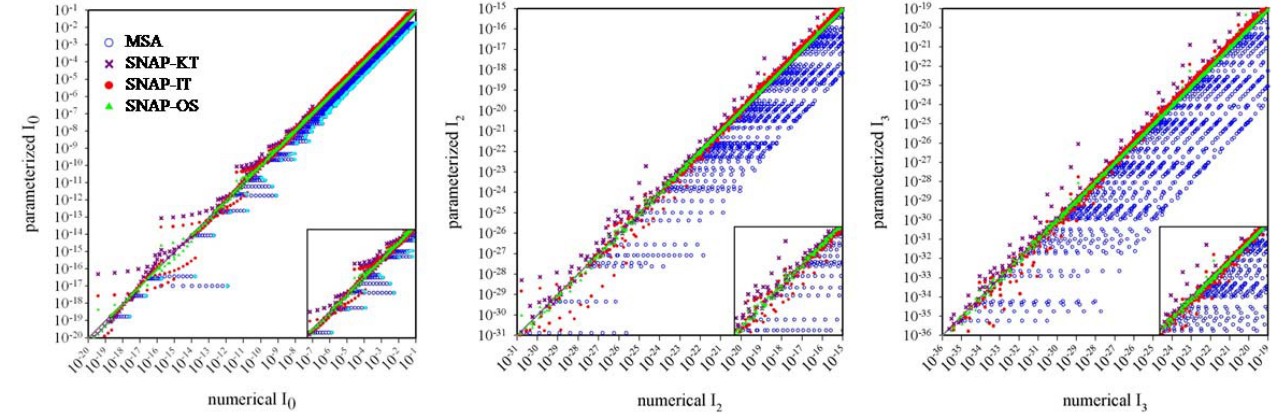
Figure 4: Comparing parameterized immersion freezing rates (ordinate) against the numerical solutions (abscissa). Panels from left to right are rates of the zeroth, second, and third moments, respectively. Results from MSA, SNAP-KT, SNAP-IT, and SNAP-OS are represented by the blue circles, purple crosses, red dots and green triangles, respectively. At the lower right corner of each panel is a close-up of the central section. In the left panel, MSA points with the largest σ are highlighted with cyan dots.